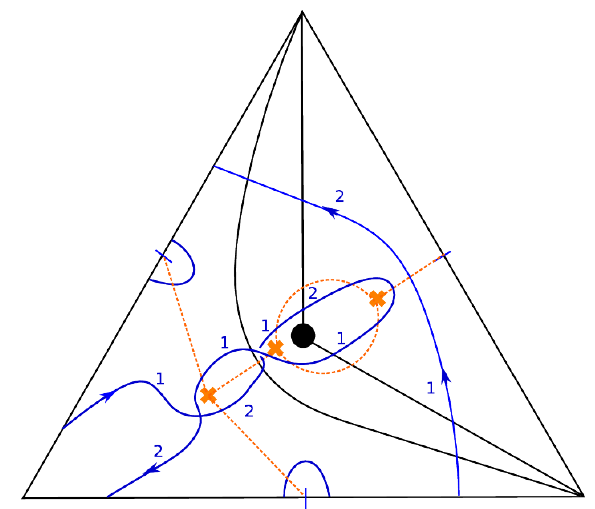
Figure 5. One of the lifted paths contributing to the term (4.14).